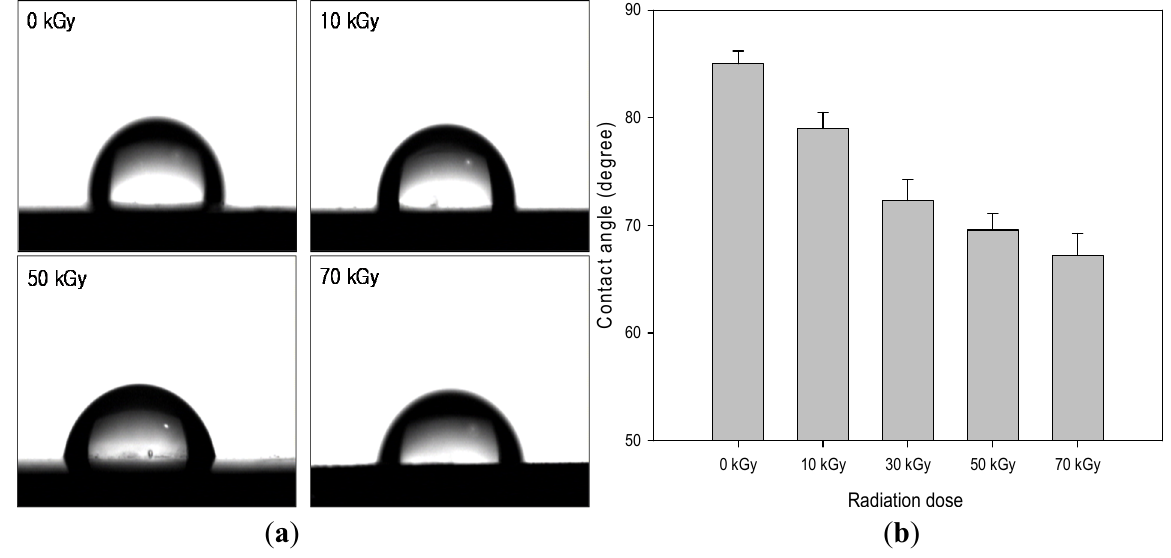
Figure 5. Contact angle of PU (1 phr)/HDPE composites at various absorption doses. ( a ) Water contact angle images; ( b ) water contact angle